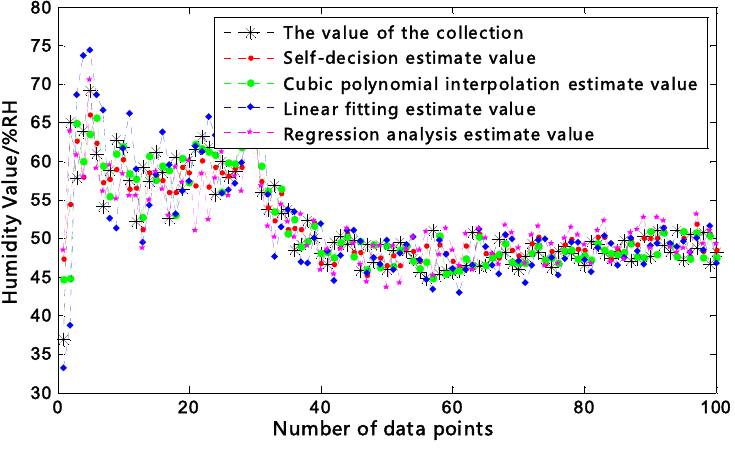
Figure 7. Comparison of the experimental results and the estimated temperature of Node A.